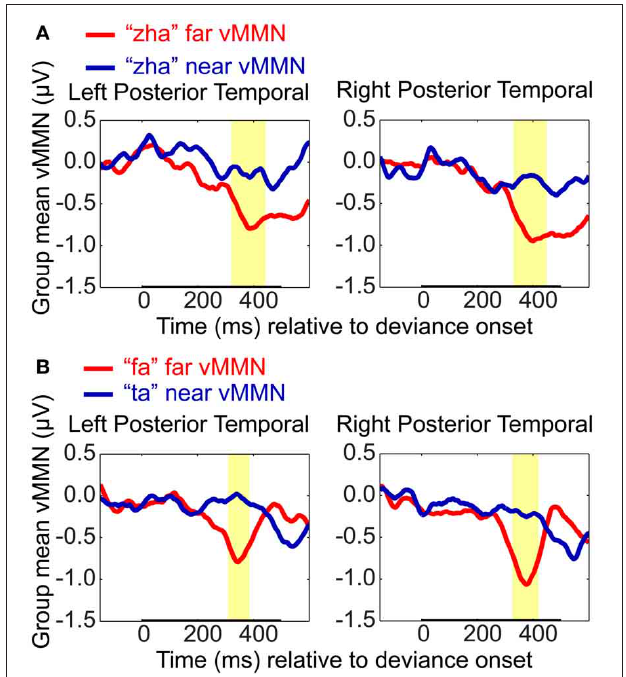
FIGURE 8 | VMMN comparisons. Group mean vMMN difference waves (deviant minus standard) from EOI means were compared to test whether syllable distance ( far vs. near ) predicted relative vMMN magnitude. Comparisons were (A) “zha” in the far context vs. “zha” in the near context, and (B) “fa” ( far context) vs. “ta” ( near context). Statistical comparisons were performed over the times indicated by the heavy black line along the time axis. Highlighted regions denote statistically significant ( p < 0 . 05) differences in the vMMNs corrected for multiple comparisons over time. For display purposes only, difference waves were smoothed with a 41-sample moving average.